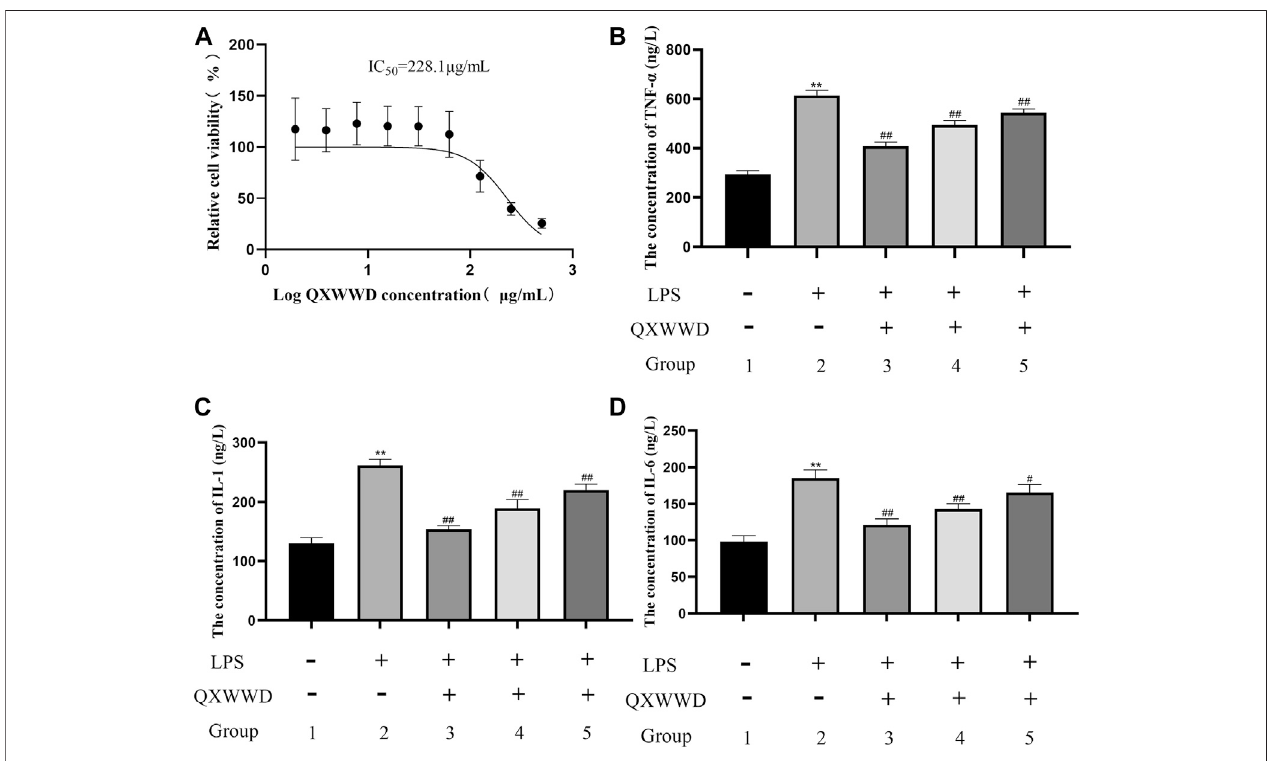
FIGURE 11 | Cell viability assay and measurement of pro-in fl ammatory cytokines 1: control group; 2: model group (1 μ g/ml LPS); 3: high dose group (80 μ g/ml QXWWD+1 μ g/mlLPS);4:mediumdosegroup(40 μ g/mlQXWWD+1 μ g/mlLPS);5:lowdosegroup(20 μ g/mlQXWWD+1 μ g/mlLPS). (A) Relativecellviability, (B) The concentration of TNF- α in cell-free supernatants, (C) The concentration of IL-1 in cell-free supernatants, (D) The concentration of IL-6 in cell-free supernatants.